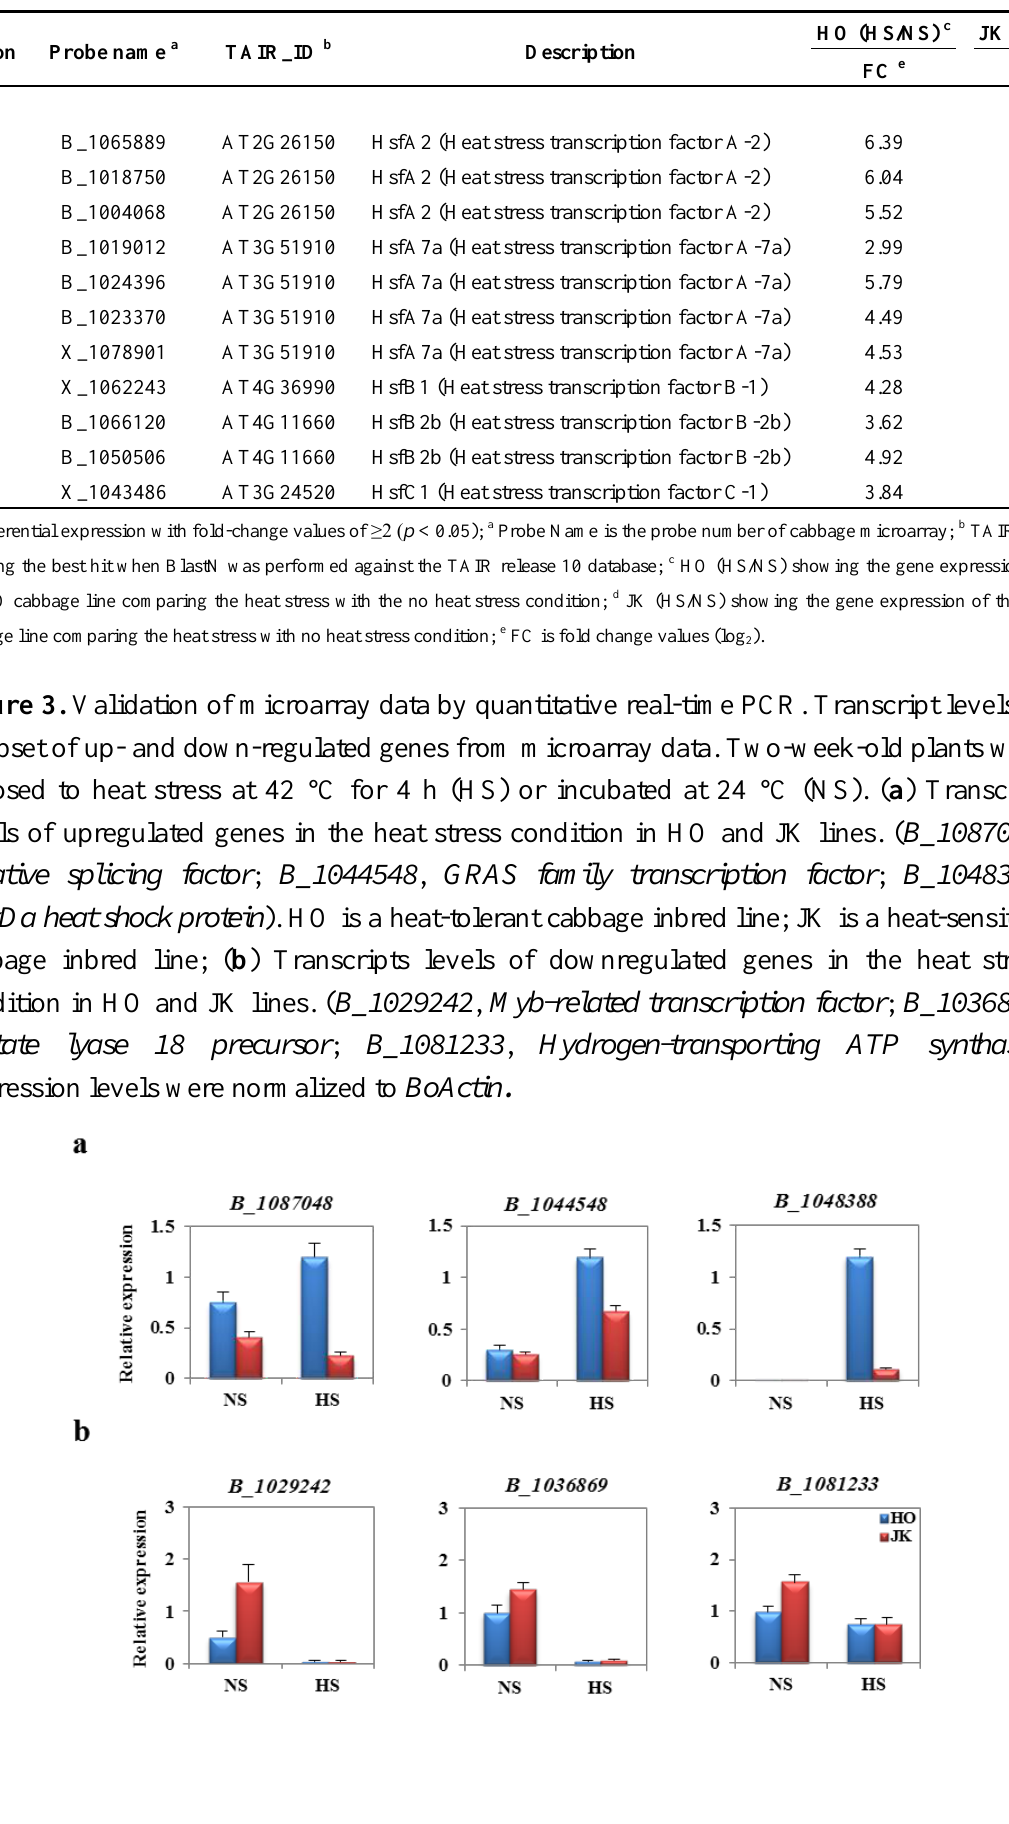
Table 2. Differentially expressed heat stress transcription factors genes under heat stress in inbred line HO and JK.